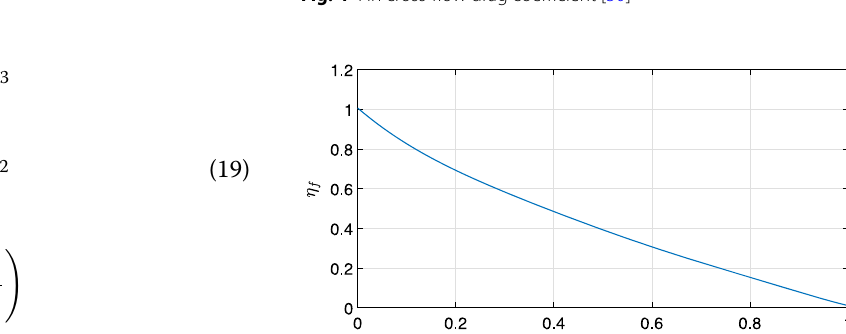
Fig. 4 Fin cross-flow drag coefficient [30]